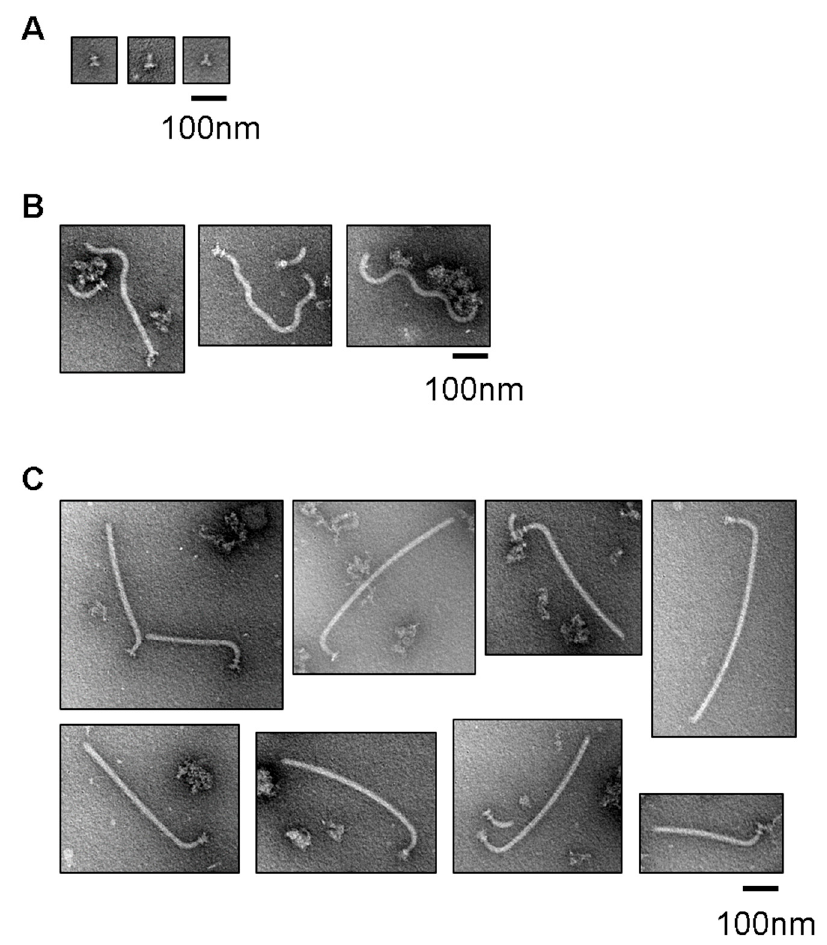
Figure 4. Negative-staining electron micrographs of the basal bodies after transport assay of the filament-type proteins purified from the IMVs. The basal bodies after transport assay using the IMVs prepared after first reaction with FlgD and FliK but without FlgE ( A ), with FlgD and FlgE but without FliK ( B ), and with FlgD, FlgE, and FliK ( C ). The concentrations of FlgD, FlgE, FliK, FliH 2 / FliI complex, FliJ, and ATP–Mg in the first reaction mixture were 4 µ M, 4 µ M, 4 µ M, 1.5 µ M, 0.25 µ M, and 5 mM, respectively. The concentrations of FliC / FliS, FliD / FliT, FlgK / FlgN, and FlgL / FlgN in the transport assay mixture for the filament-type proteins were 1 µ M each and those of the FliH 2 / FliI complex, FliJ, and ATP–Mg were the same as in the first reaction mixture.